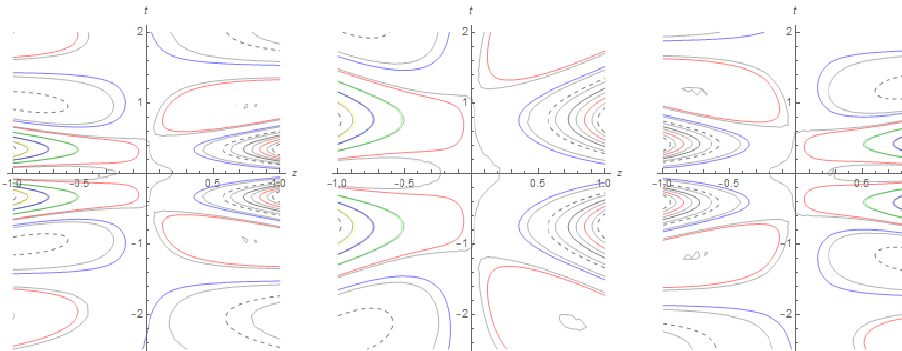
Figure 14. Contour slots for Figure 13.